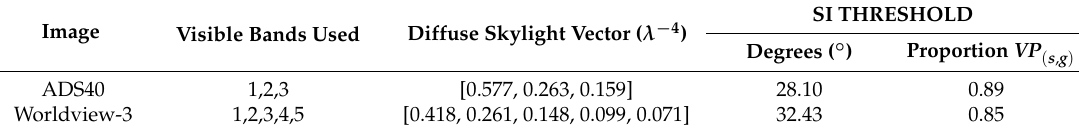
Table 2. Diffuse skylight vectors and SI shadow thresholds for ADS40 and Worldview